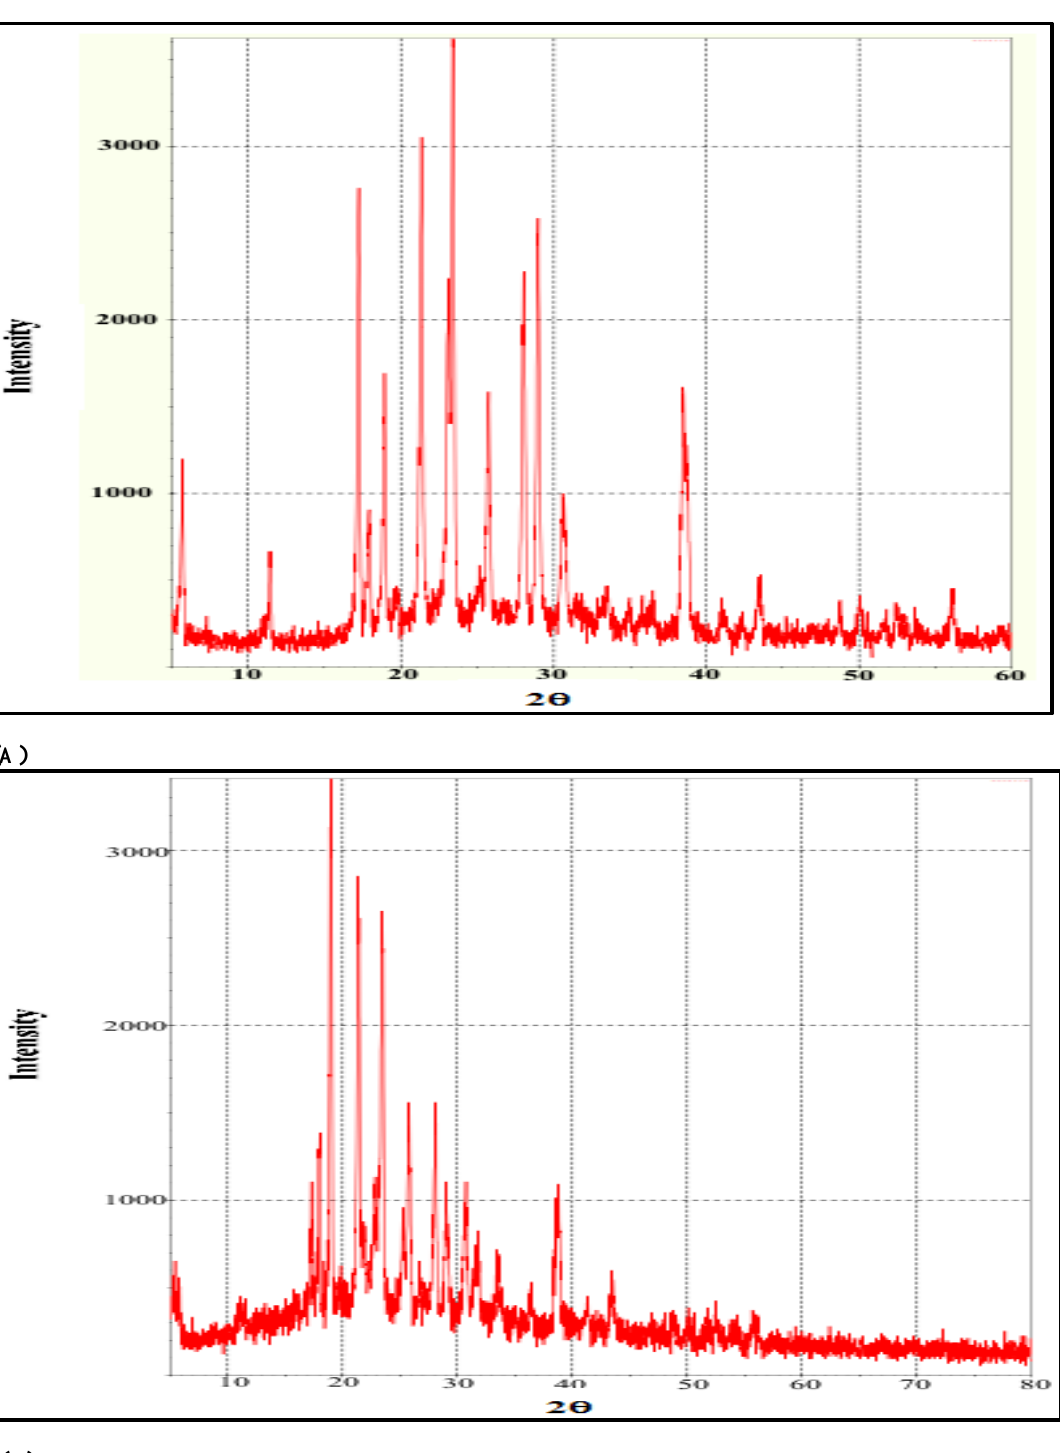
Figure (8) X-ray diffractions of (A) Pure BFN, (B) BF